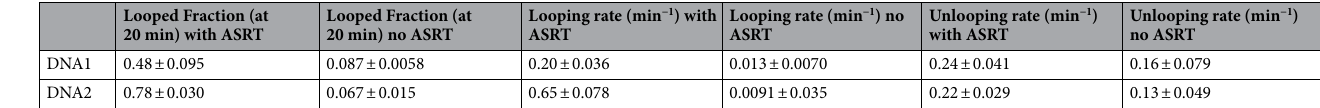
Table 1. looping fraction and rate of DNA induced by